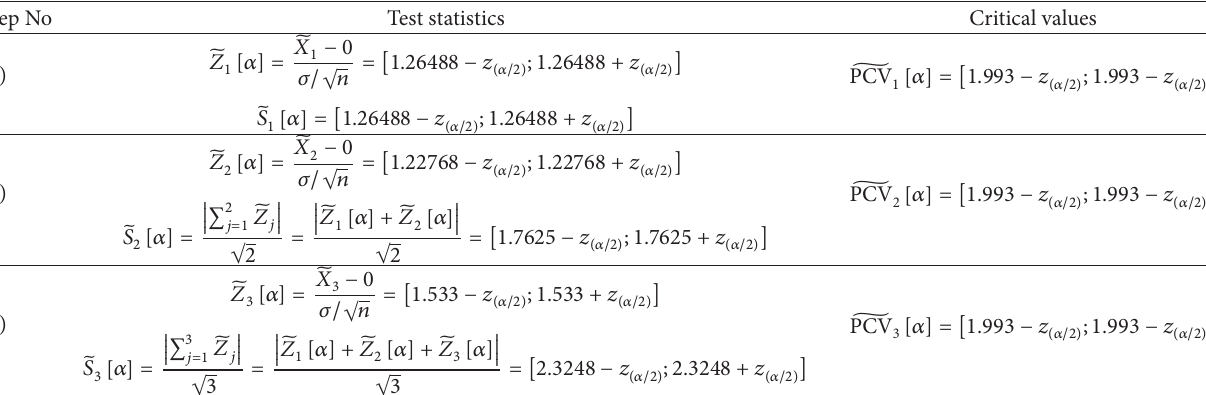
Table 3: Summarized calculations for fuzzy group sequential test.